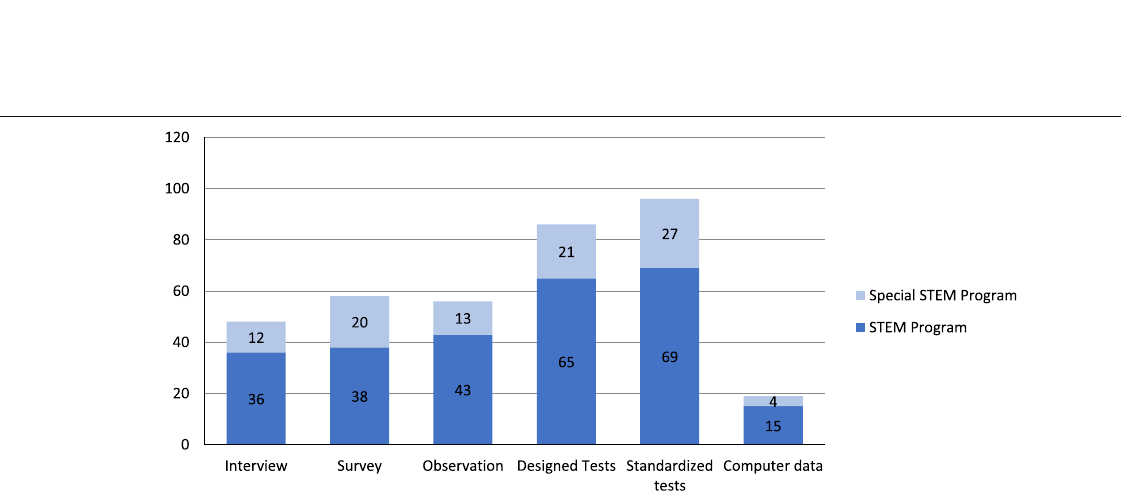
Fig. 21 The number of projects categorized by the type of data collection methods